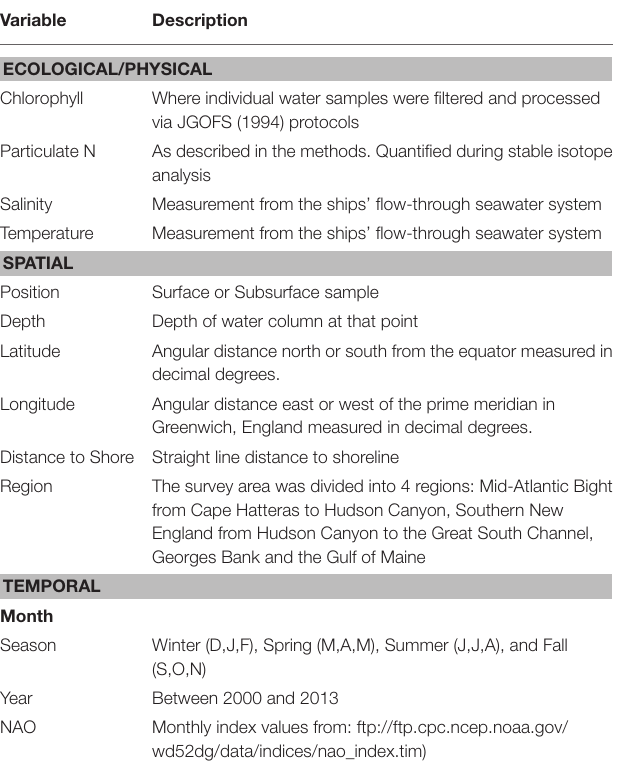
TABLE 2 | Predictor variables used in random forest modeling.